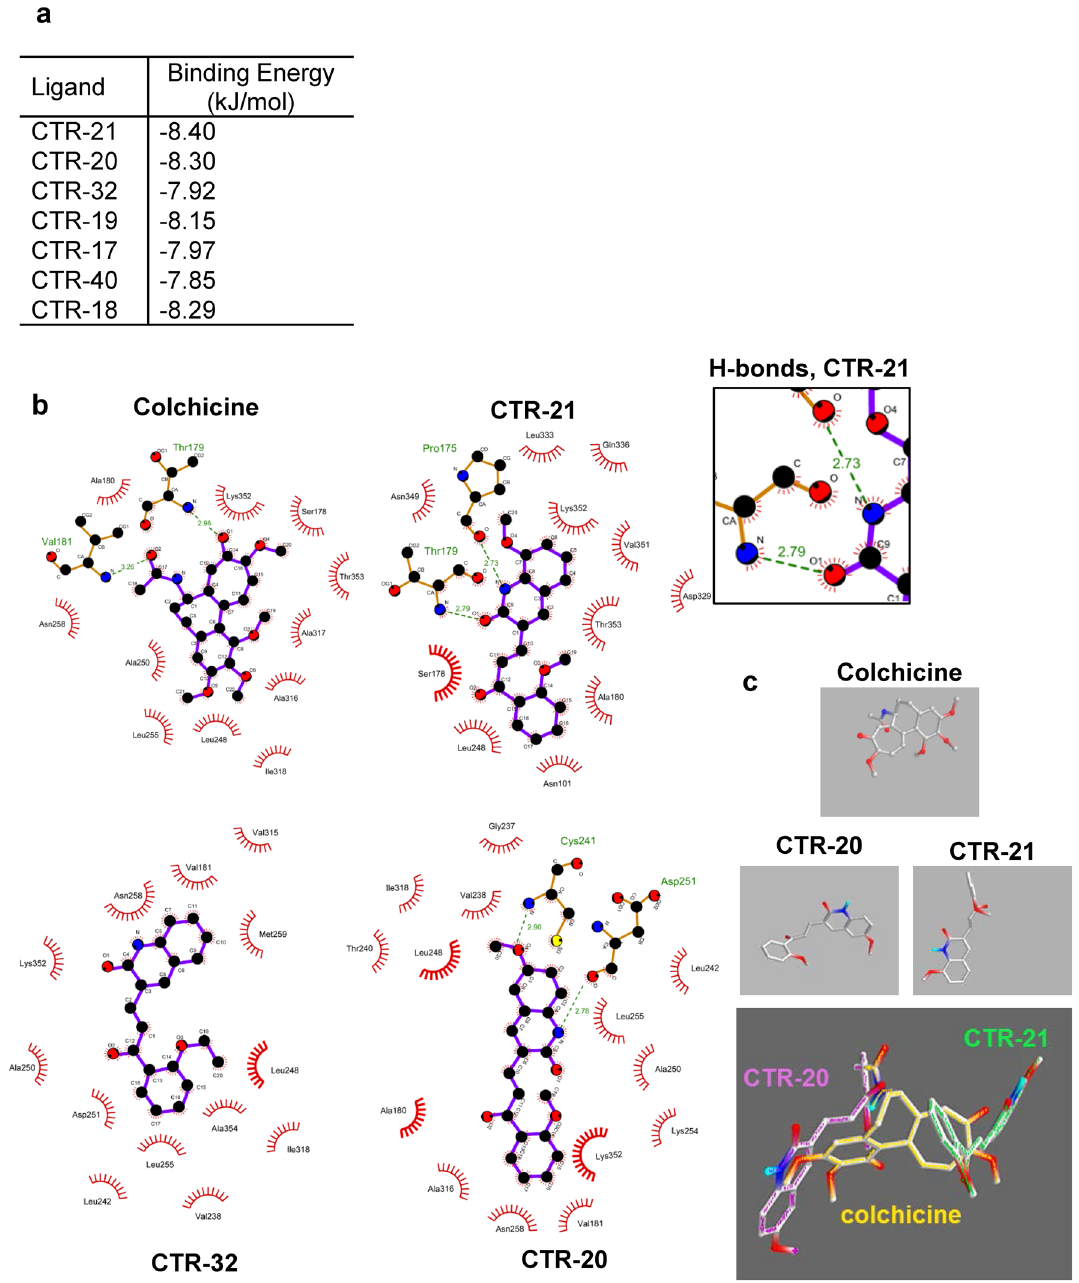
Figure 3. CTR-21 and CTR-32 may inhibit microtubule polymerization and compete with colchicine through its binding to the pocket located at the colchicine- and gatorbulin-binding pockets in β-tubulin. ( a ) CTRs dock with similar energies with alpha/beta tubulin. Shown are the best binding energies of CTRs in the interface between alpha and beta tubulin (PDB:4O2B). ( b ) CTR-21 is predicted to form hydrogen bonds with both α- and β-tubulin overlapping the colchicine-binding site. Two-dimensional representations of colchicine, CTR- 20, CTR-21 and CTR-32 bound to interface between alpha and beta tubulin (PDB:4O2B) according to data obtained using the LigPlot + software 35 . Green lines indicate hydrogen bonds (with bond length in Ångstrom), red hemi-circles depict hydrophobic interactions. The color codes are as follows: oxygen, red; nitrogen, blue; sulfur, yellow; and carbon, black. The box is the enlarged portion of CTR-21 that forms hydrogen bonds with tubulin residues. ( c ) CTR-21 binds perpendicularly to colchicine. Three-dimensional representation of CTR-20 and CTR-21 bound in lowest energy poses from ( b ), in comparison with colchicine. Color codes are: oxygen, red; nitrogen, blue; and carbon, grey. In the bottom panel, the color codes of compound names and those of compound structures are the